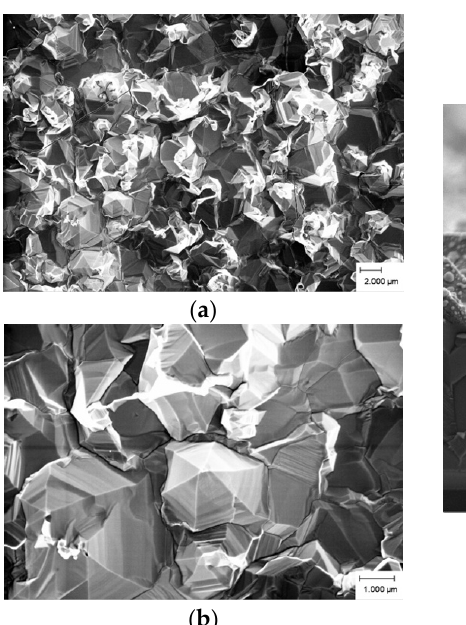
Figure 5. FESEM images of as-deposited ZnO products prepared at 700 ˝ C. ( a ) low magnification; ( b ) high magnification; and ( c ) cross section.